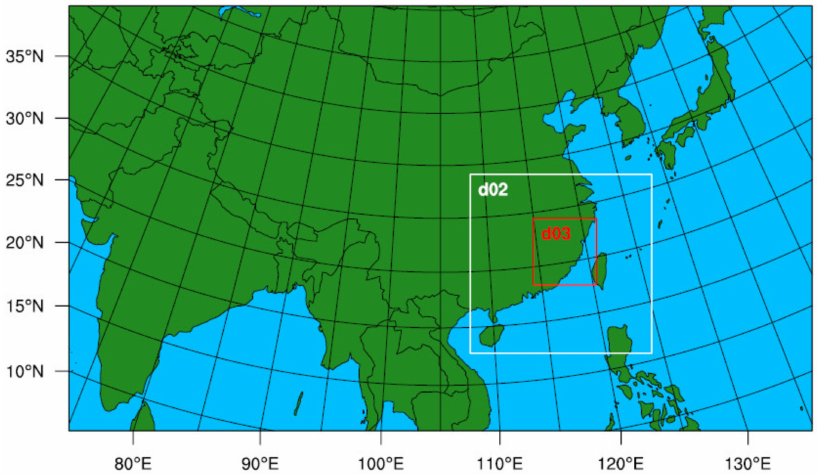
Figure 2. Three domains with resolutions of 27 (d01), 9 (d02), and 3 km (d03) in the WRF. The innermost domain was centered on Nanping City of Fujian Province, where the flood happened on 15 June 2010. Fifty levels were set in the vertical section. The land use/land cover and topography driven data from the U.S. Geological Survey (USGS) were set at 2 min spatial resolution for d01 and d02, but 30 s for d03. The simulations of the three domains were all initiated at 00 UTC 14 June 2010 with an integration time span of 6 h and the model spin-up time of about 3 h (d01) and 1 h (d02 and d03).